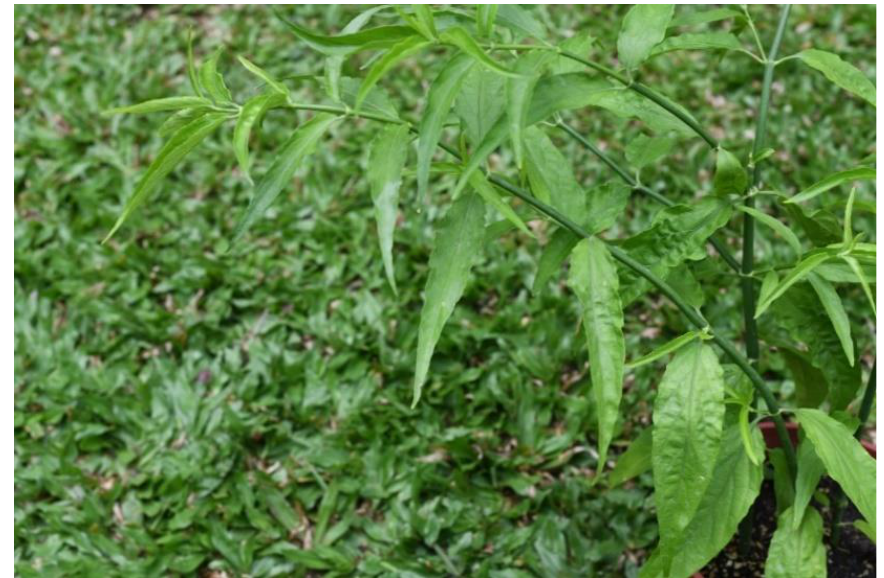
Figure 1. Clinacanthus nutans plant (Photo by W.Y. Ong).